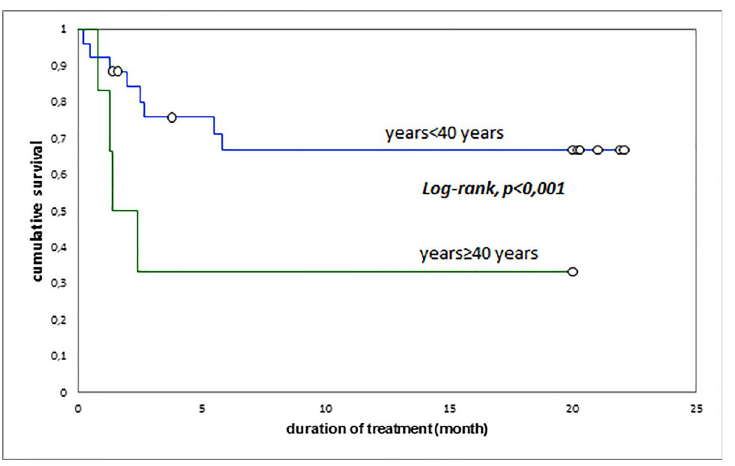
Fig 4. Survival curves of the patients by